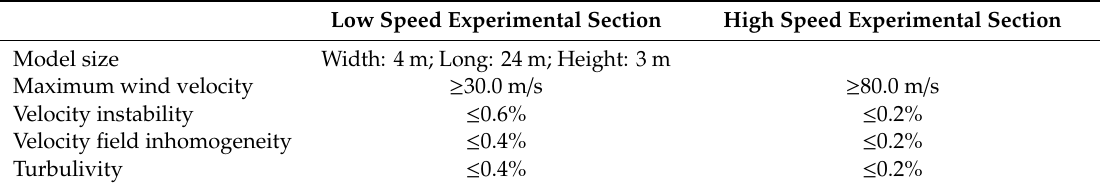
Table 6. Basic parameter of Wind tunnel model.